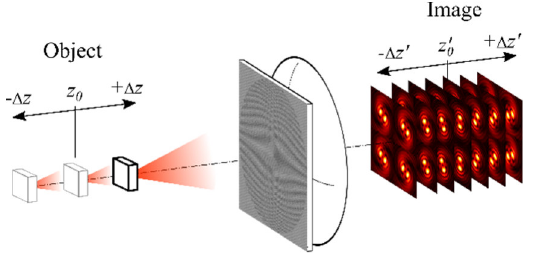
Fig. 1. Combination of the MPM and the DH-PSF. The two rotating spots created by the SPM are replicated to four copies